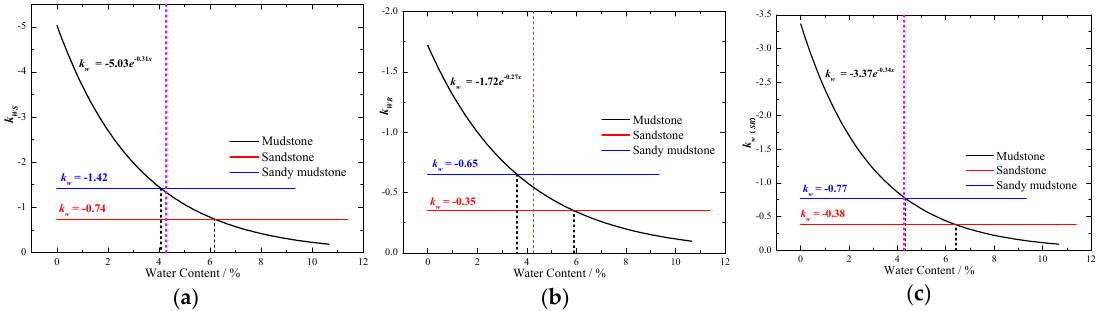
Figure 10. Sensitivity coefficient of moisture content for rock samples . ( a ) Peak stress, ( b ) residual stress, ( c ) difference between peak stress and residual stress.